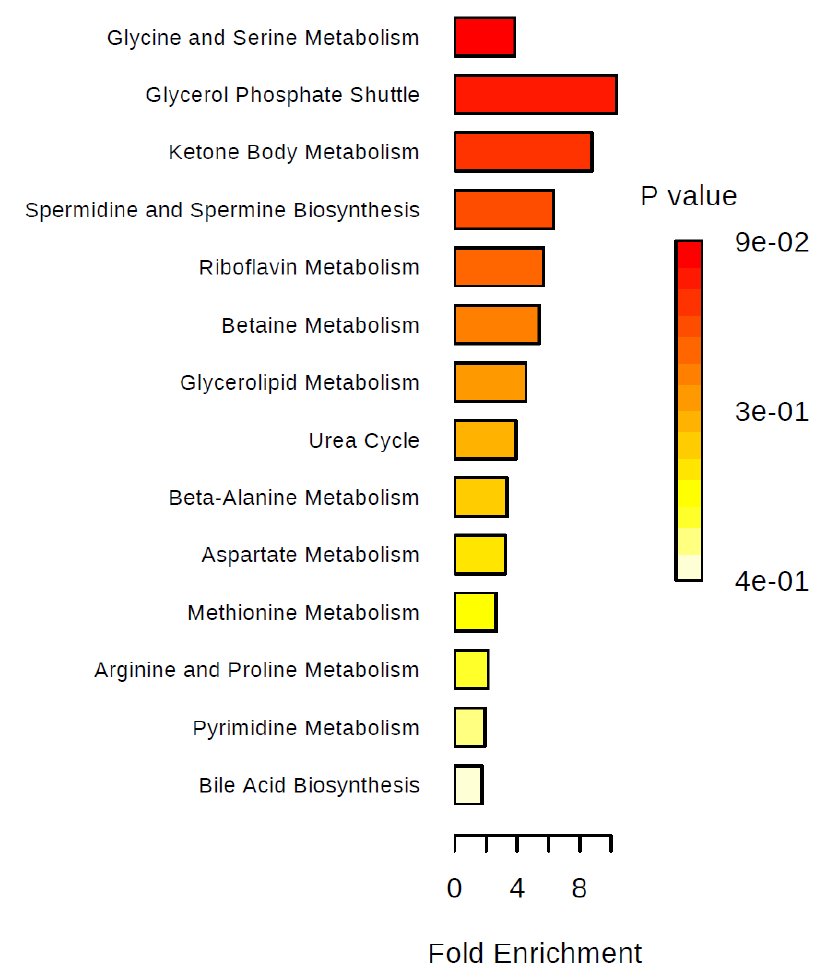
Figure 7. Summary plot for over-representation analyses (ORA). Metabolites that were different between pre-cachectic and non-cachectic patients. For each of the listed pathways, the respective metabolites identified are listed below: Glycine and serine metabolism: L-arginine and L-methionine (2/59); glycerol phosphate shuttle: Hydroquinone (1/11); ketone body metabolism: Acetone (1/13); spermidine and spermine biosynthesis: L-methionine (1/18); riboflavin metabolism: Hydroquinone (1/20); betaine metabolism: L-methionine (1/21); glycerolipid metabolism: Hydroquinone (1/25); urea cycle: L-arginine (1/29); beta-alanine metabolism: Uracil (1/34); aspartate metabolism: L-arginine (1/35); methionine metabolism: L-methionine (1/43); arginine and proline metabolism: L-arginine (1/53); pyrimidine metabolism: Uracil (1/59); bile acid biosynthesis: Cholic acid (1/65).